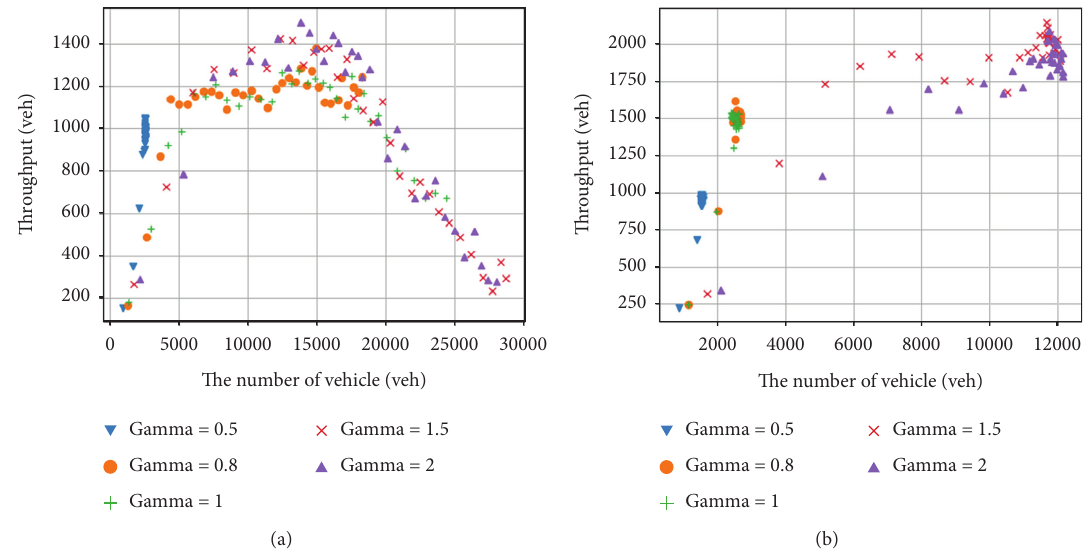
Figure 8: The throughput of an 8 × 8 network with one strategy and fixed phasing time for Γ � 0.5, 0.8, 1, 1.5, 2. The throughput indicates the ability of method to manage the traffic, while it has an increasing traffic trend. (a) Fixed time traffic light. (b) The proposed traffic light phasing without ETL.